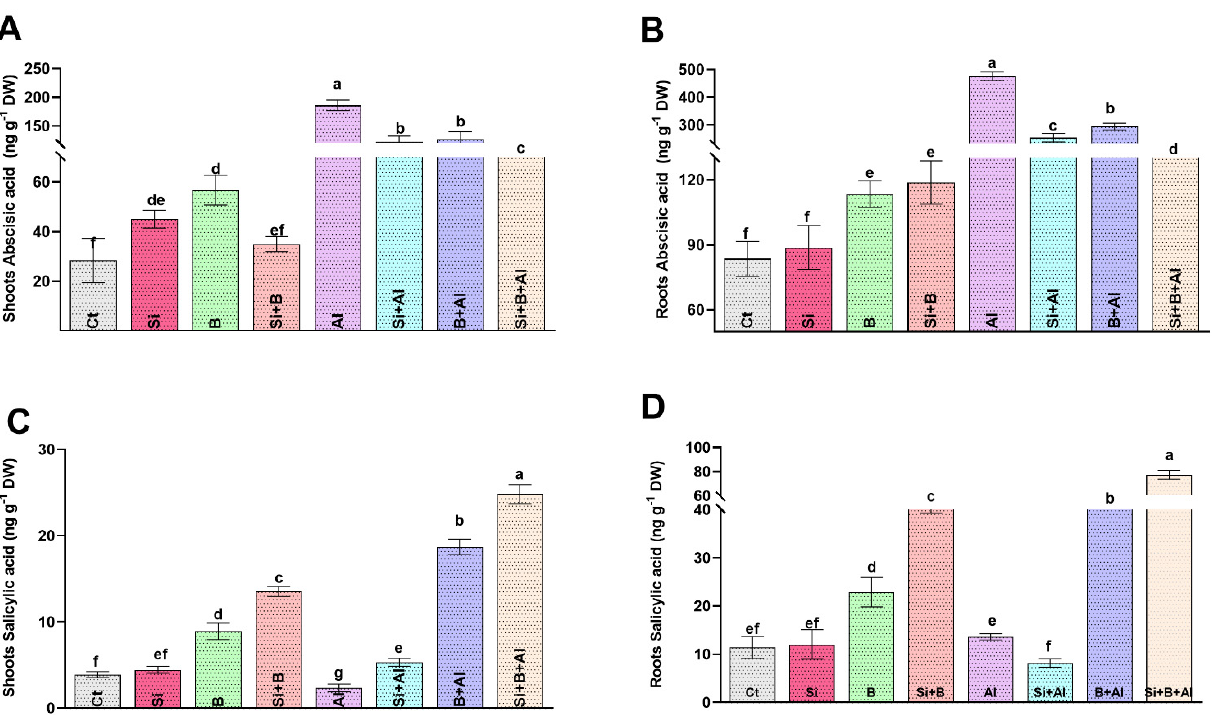
Figure 4. Endogenous hormonal (abscisic acid and salicylic acid) regulation by the sole and interac- tive effects of Si and B administration under Al-induced stress in date palm shoots and roots. ( A , B ) Abscisic acid, ( C , D ) Salicylic acid. The bars illustrate means (of four replications) ± standard error. The means with different letters are significantly different ( p < 0.05) as evaluated by the Duncan Multiple Range Test